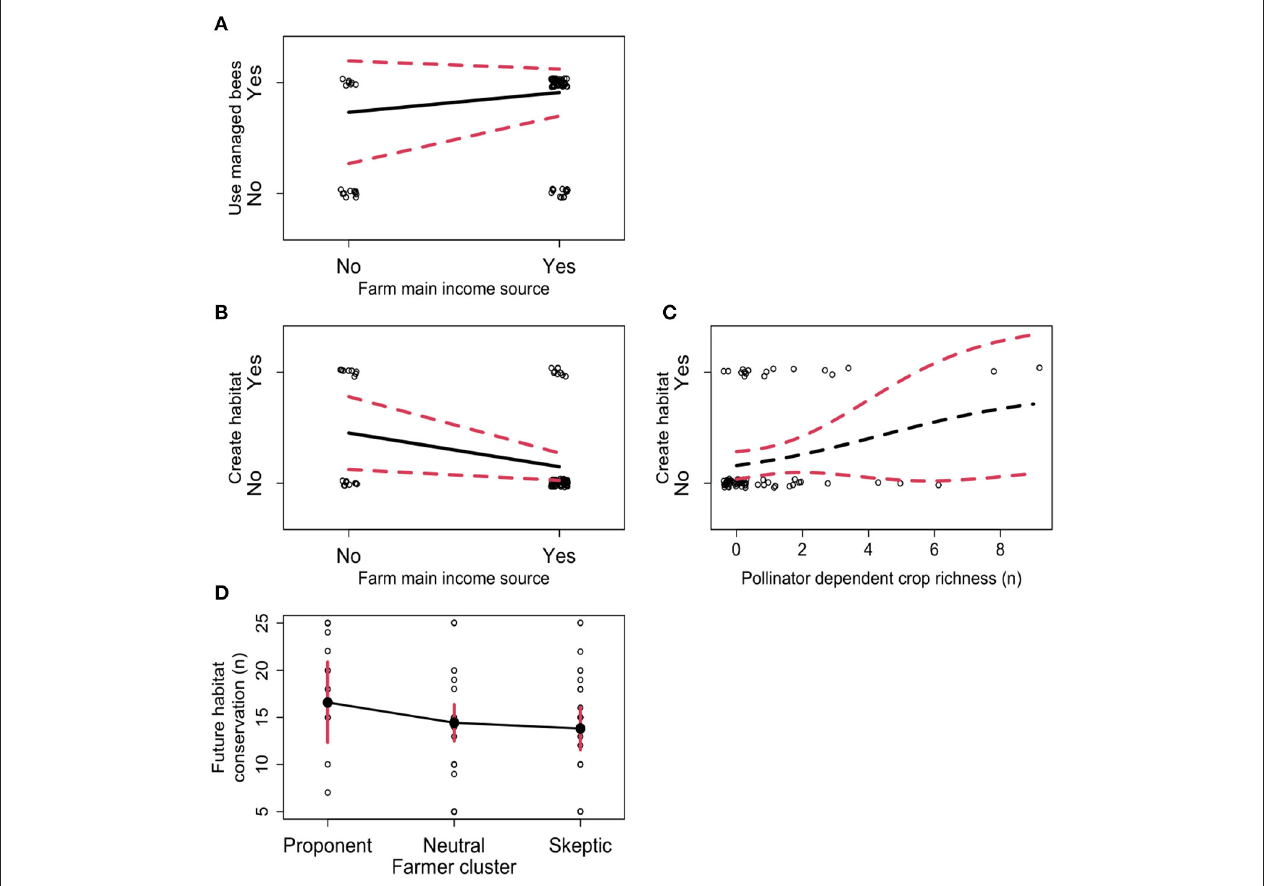
FIGURE 5 | Model averaged predictions plotted with raw survey data for variables mediating (A) the use of managed bees, (B,C) the creation of pollinator habitat, and (D) future participation in pollinator habitat conservation programs. (A) The use of managed bees increased when farming was the main household income source. (B) The creation of pollinator habitat decreased when farming was the main household income source and (C) was positively correlated with the richness of pollinator-dependent crops. (D) Future participation in programs to create pollinator habitat had a weak positive relationship with farmers who viewed